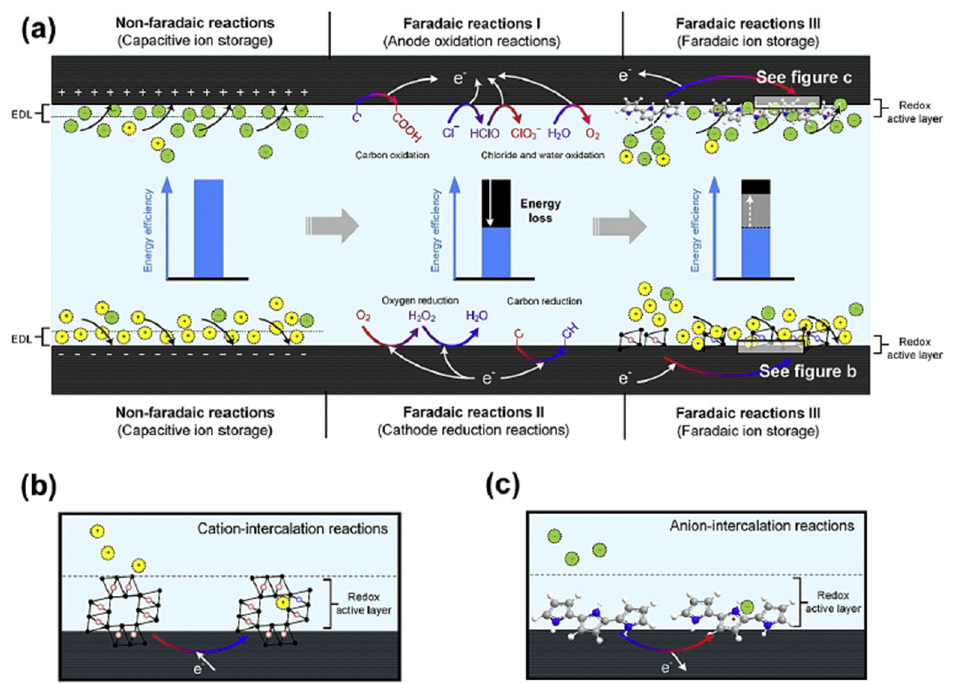
Figure 14. ( a – c )Schematic presentation of three types of faradaic processes (anodic oxidation, ca- thodic reduction, and faradaic ion storage processes) [114]. reduction, and faradaic ion storage processes)